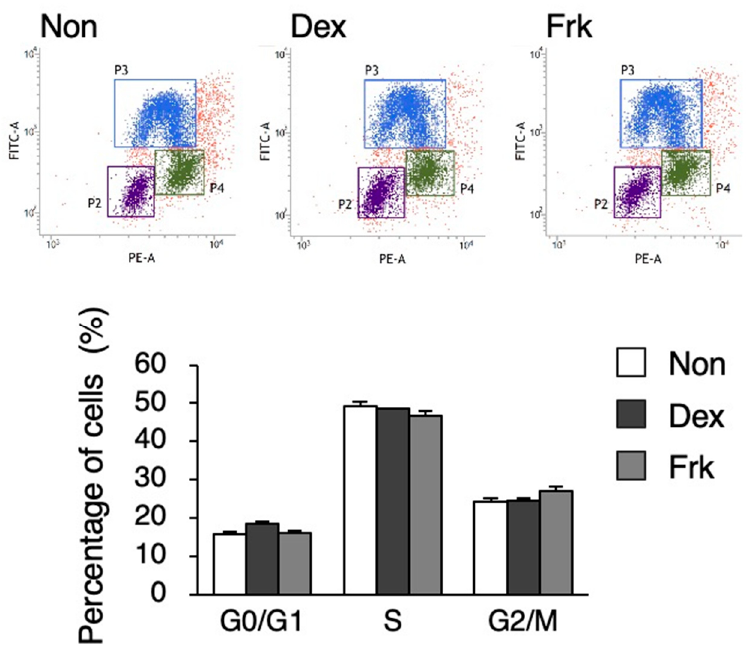
Figure 2. Cell cycle analysis after Dex and Frk stimulation in hiPSCs. Percentage of the cells in G0 / G1; the S and G2 / M phase in the hiPSCs after Dex or Frk stimulation is shown in the graph. Data are presented as the means ± SEM; n = 3 for each comparison.